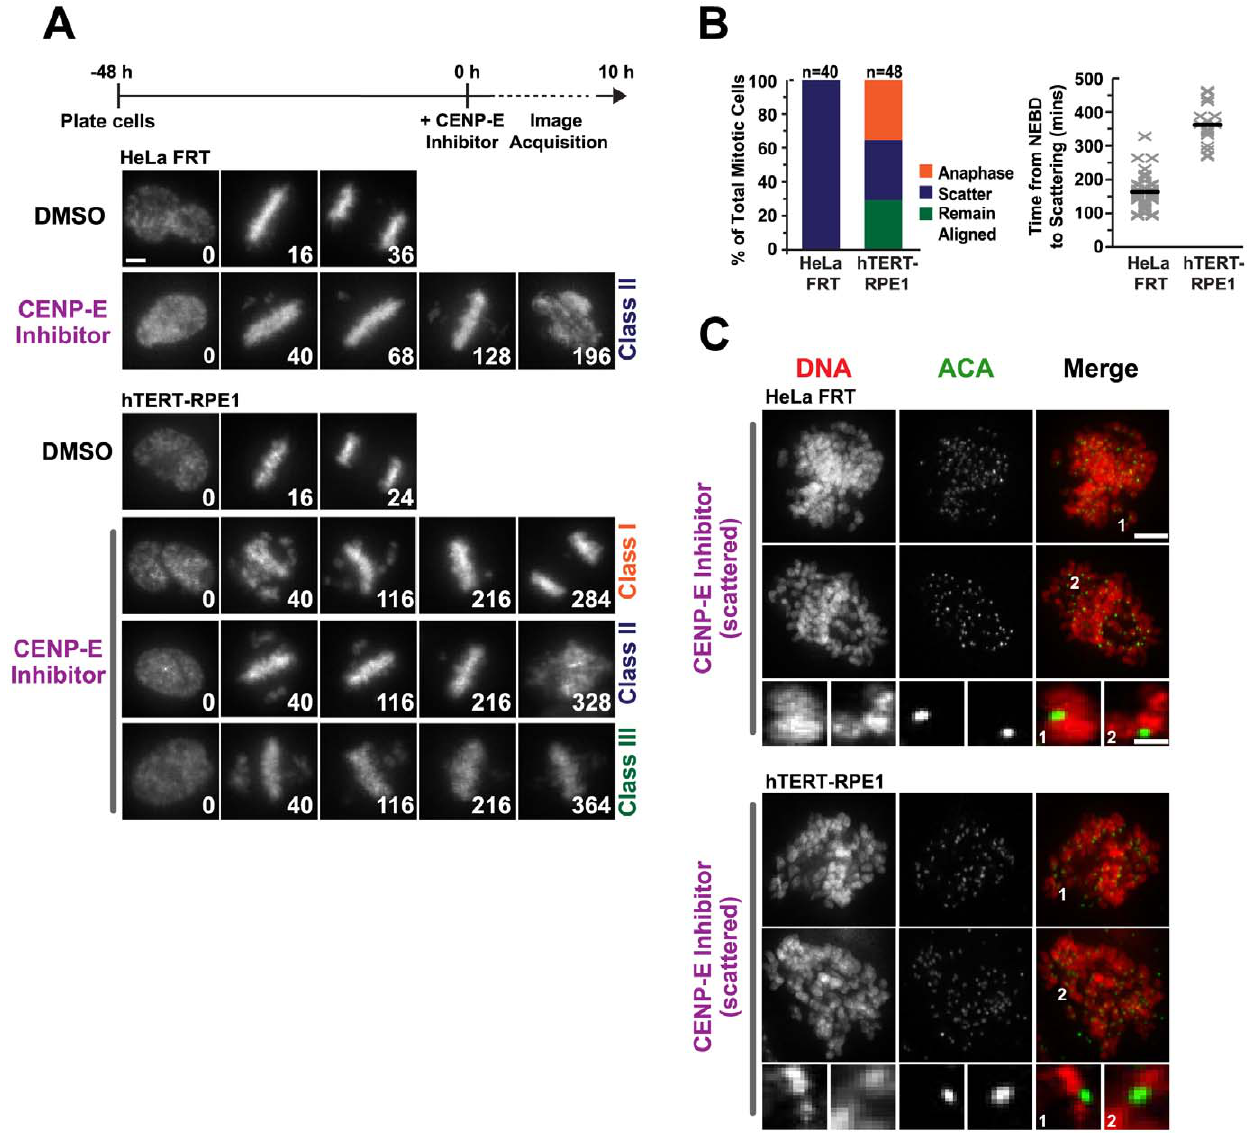
Figure 3. Chromosome scattering occurs in karotypically normal cells. ( A ) Selected images from time-lapse imaging sequences of cells expressing histone H2b:mRFP for HeLa FRT and hTERT-RPE1 cells treated with a CENP-E inhibitor. Time (in mins) is indicated on the lower right of each panel; time 0 is NEBD. The experimental scheme is depicted above the images. Scale bar, 5 m m. ( B ) Comparison and quantification of the cellular response to the CENP-E inhibitor. ( C ) Immunofluorescence images of scattered cells that are stained for DNA and centromere marker ACA. Individual chromatids are seen off the plate in the scattered state for both cells lines treated with the CENP-E inhibitor. Scale bar, 5 m m; magnified image 1 m m.